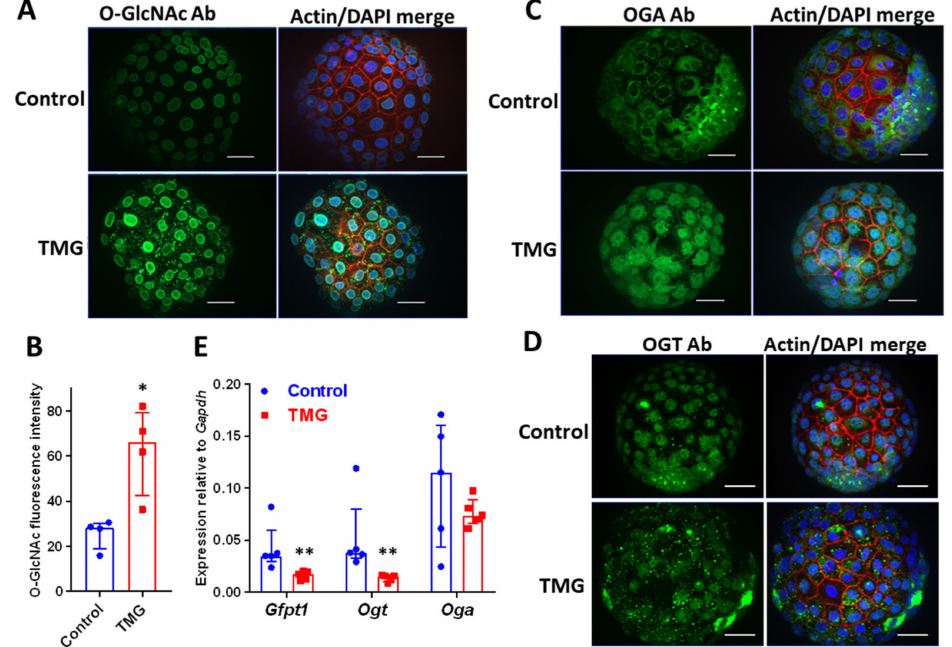
Figure1. E4.5mouseblastocystswereculturedfor24htoE5.5intheabsence(control)orpresenceof5 µ M TMG. ( A ) Fixed blastocysts stained with phalloidin to label actin filaments (red), DAPI to label nuclei (blue) and RL2 anti-O-GlcNAcylated protein antibody (green). Fluorescence microscopy was performed with optical sectioning, and maximum intensity projections of optical sections are shown. Scale bars 20 µ m. ( B ) Quantification of RL2 anti-O-GlcNAcylated protein antibody mean fluorescence intensity in blastocysts (arbitrary units) ( n = 4 blastocysts from two independent experiments; median ± interquartile range (IQR); * p < 0.05 Control vs. TMG; Mann–Whitney). ( C ) Fixed blastocysts were stained with anti-OGA antibody (green) or ( D ) anti-OGT antibody (green), together with phalloidin (red) and DAPI (blue), and imaged as described. Maximum intensity projections are shown. Scale bars 20 µ m. ( E ) RNA was extracted from groups of ten blastocysts and qPCR was performed to measure the expression of Gfpt1 , Ogt and Oga ( n = 5; median ± IQR; ** p < 0.01 Control vs. TMG;